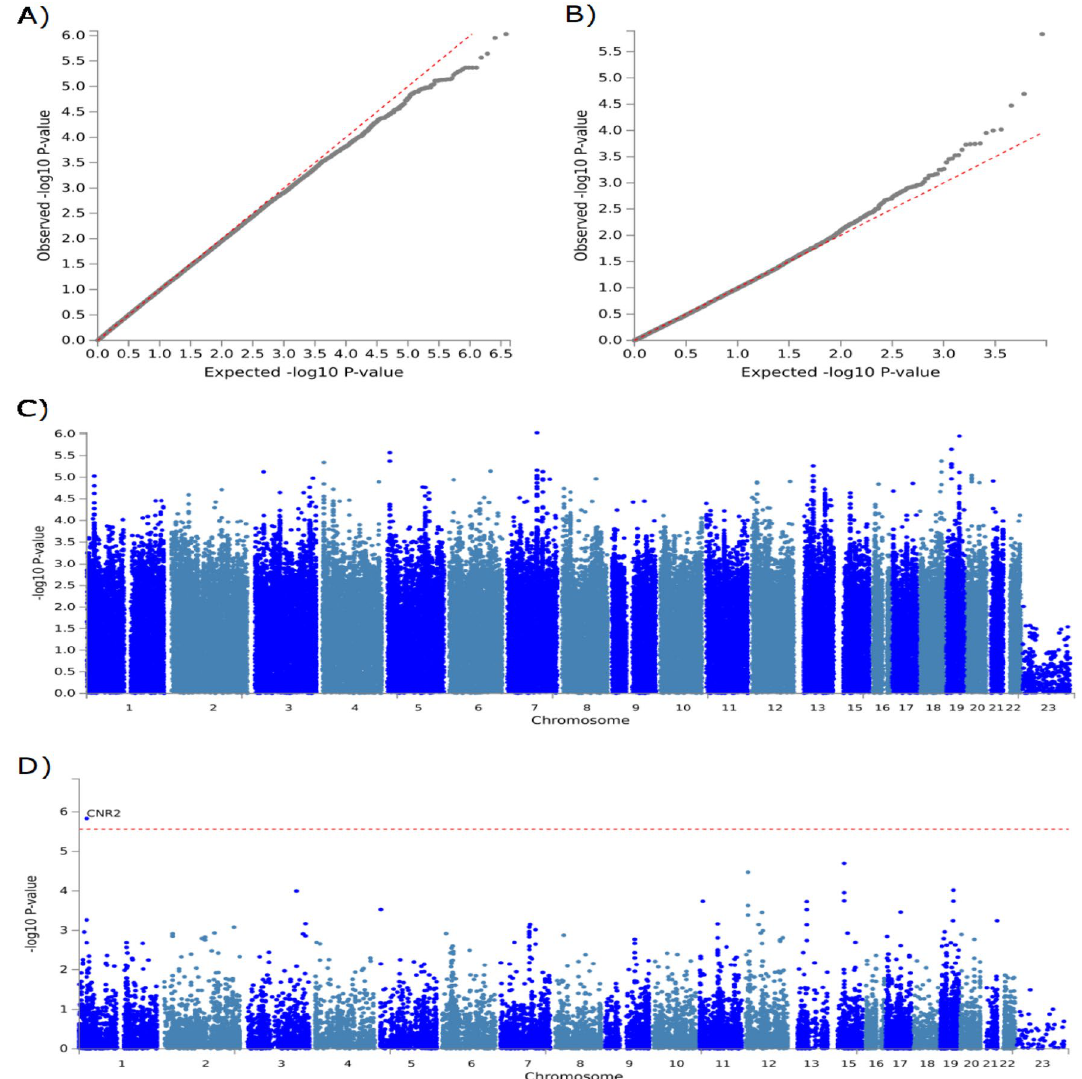
Figure 1. Q-Q plots and Manhattan plots of the DKD GWAS and gene-based test using FUMA and MAGMA. ( A ) Quantile–Quantile plot of the GWAS data. The observed p-values, on a log-10 scale, are plotted against their expected values under the null hypothesis assuming none of the sites have an effect. ( B ) Quantile–Quantile plot of the gene-based data. The observed p-values, on a log-10 scale, are plotted against their expected values under the null hypothesis assuming none of the sites have an effect. ( C ) Manhattan plot of the DKD GWAS. The plot shows the p-values on a log-10 scale (y-axis) by their chromosomal location (x-axis). ( D ) Manhattan plot of the DKD gene-based test as computed by MAGMA. The plot shows the p-values on a log-10 scale (y-axis) by their chromosomal location (x-axis). Input SNPs were mapped to 18,124 protein coding genes. Genome wide significance (Red dashed line in the plot) was defined at p = 0.05/18,124 = 2.759 × 10 –6 , labelling one gene ( CNR2 ) that reached genome wide